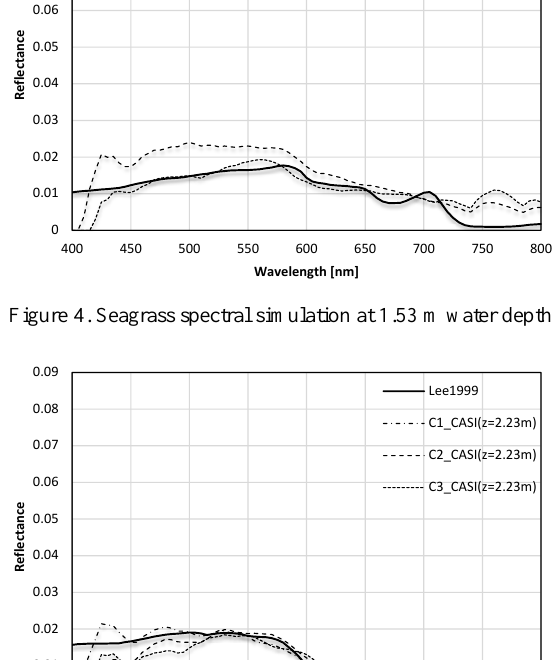
Figure 2. Sand spectral simulation at 1.03 m water depth